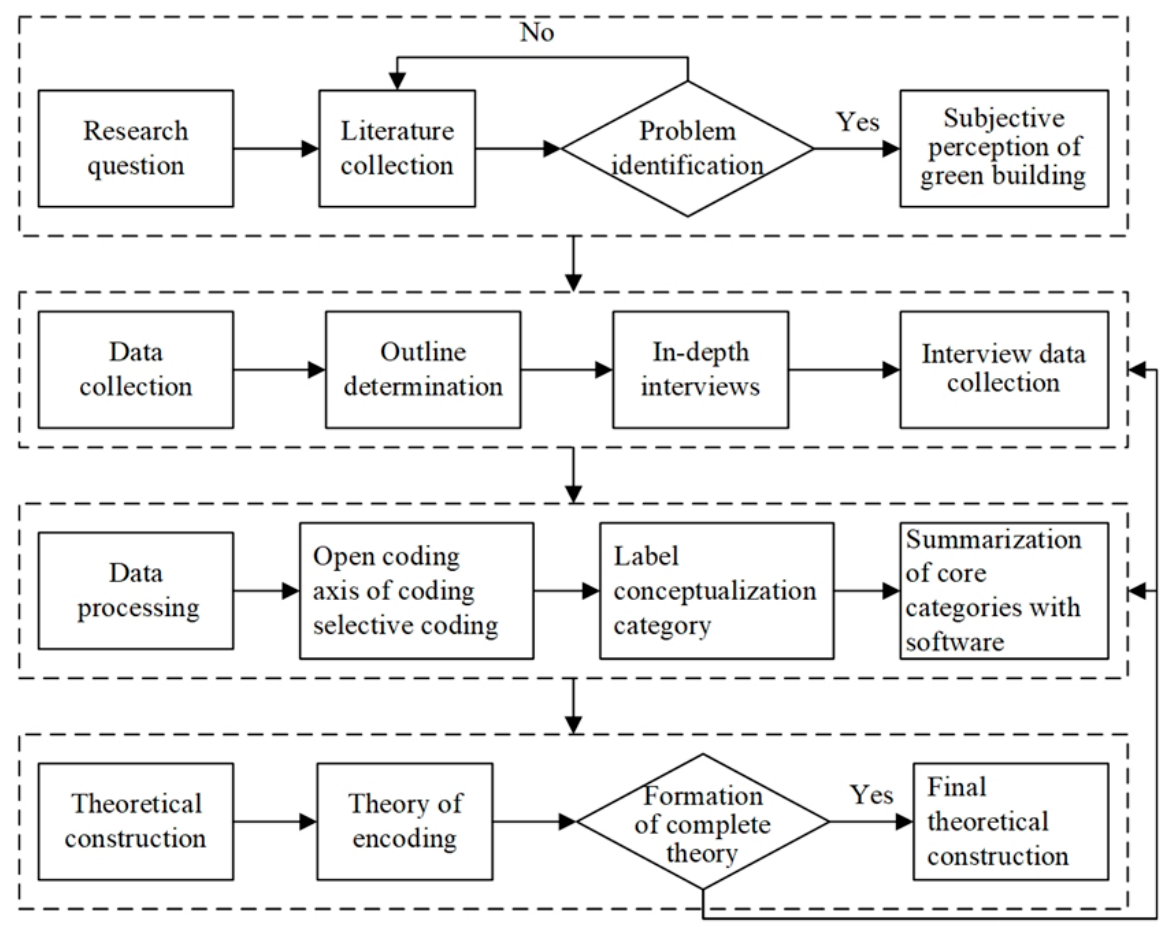
Figure 1. Analysis diagram of the research process.